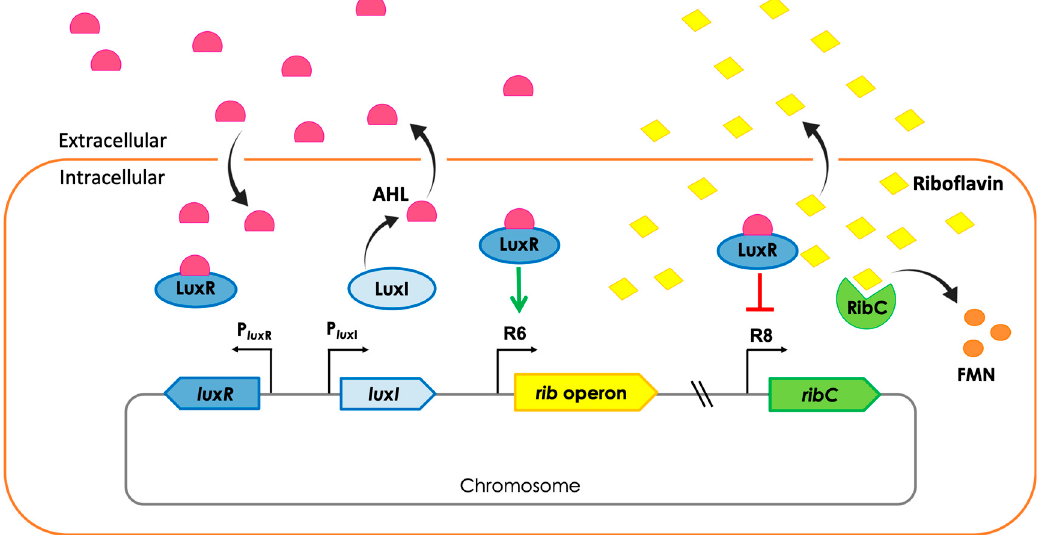
Figure 1. Engineered B. subtilis carrying the autoinduction device. In the B. subtilis ::RFai strain, LuxR binds the LuxI synthesized AHL when the signal reaches the concentration threshold in the culture. The complex AHL-LuxR binds to the luxbox in the R6 promoter and activates the transcription of the riboflavin operon ( ribDGEABHT ), generating a quorum-sensing dependent riboflavin overproduction process. Additionally, in the B. subtilis ::RFai::rRibC strain, AHL-LuxR binds to the luxbox in the R8 promoter and blocks the transcription of the flavokinase-encoding ribC gene, reducing the cell capacity to convert riboflavin to flavin monophosphate (FMN), leading to a higher accumulation of riboflavin. The rib operon and the ribC gene are 1.4 Mb distant from each other in the chromo- some.